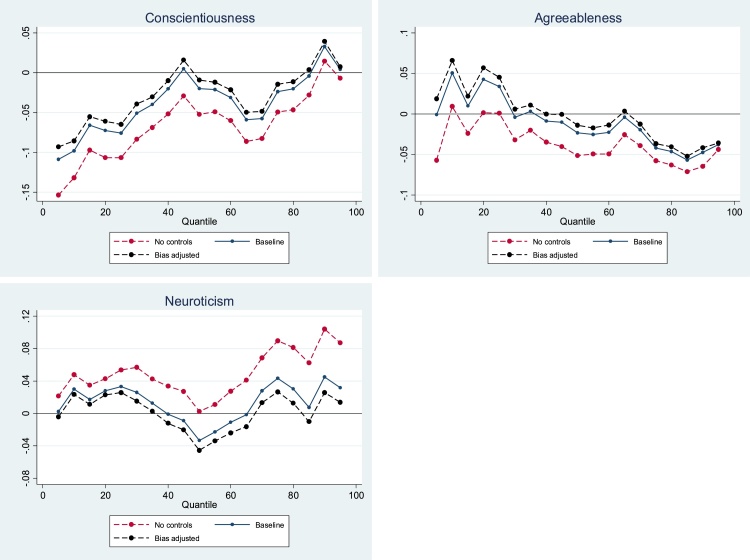
Adolescent non-cognitive skills – CRP omitted variable bias adjusted relationship.